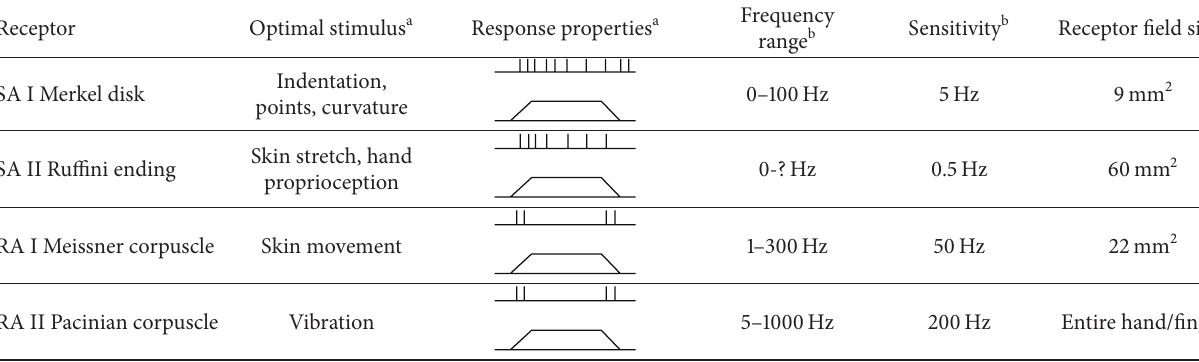
Table 1: Skin in the native hand contains multiple types of low-threshold mechanoreceptors that contribute to tactile sensation. This table lists physiological characteristics and response properties from four canonical sensory mechanoreceptor afferents that could be utilized to process signals for sensory feedback. a The optimal stimulus is the stimulus shown to result in the response shown. a , b Table values adapted from [12,